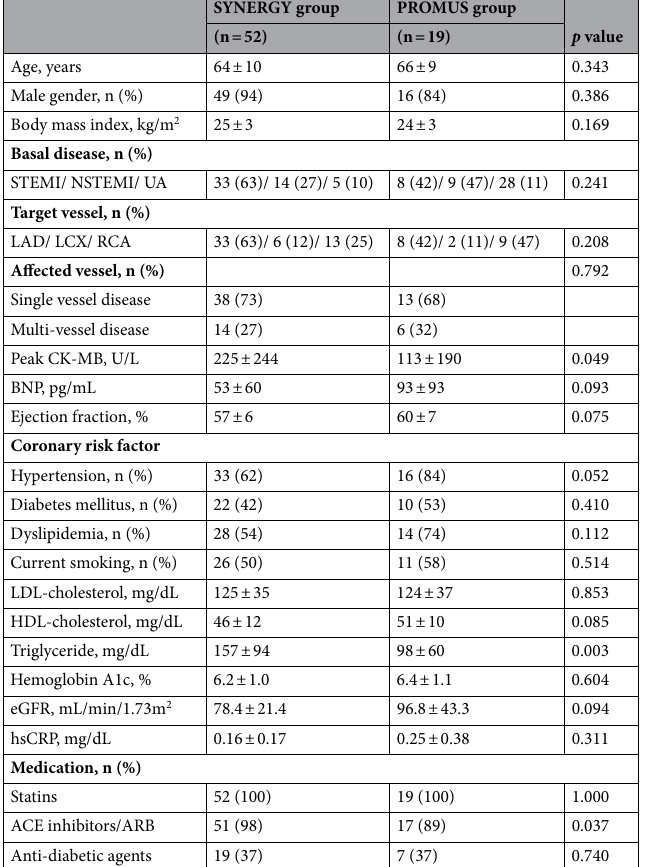
Table 1. Baseline characteristics (full analyses set). STEMI: ST-elevation myocardial infarction; NSTEMI: non ST-elevation myocardial infarction; UA: unstable angina; LAD: left anterior descending artery; LCX: left